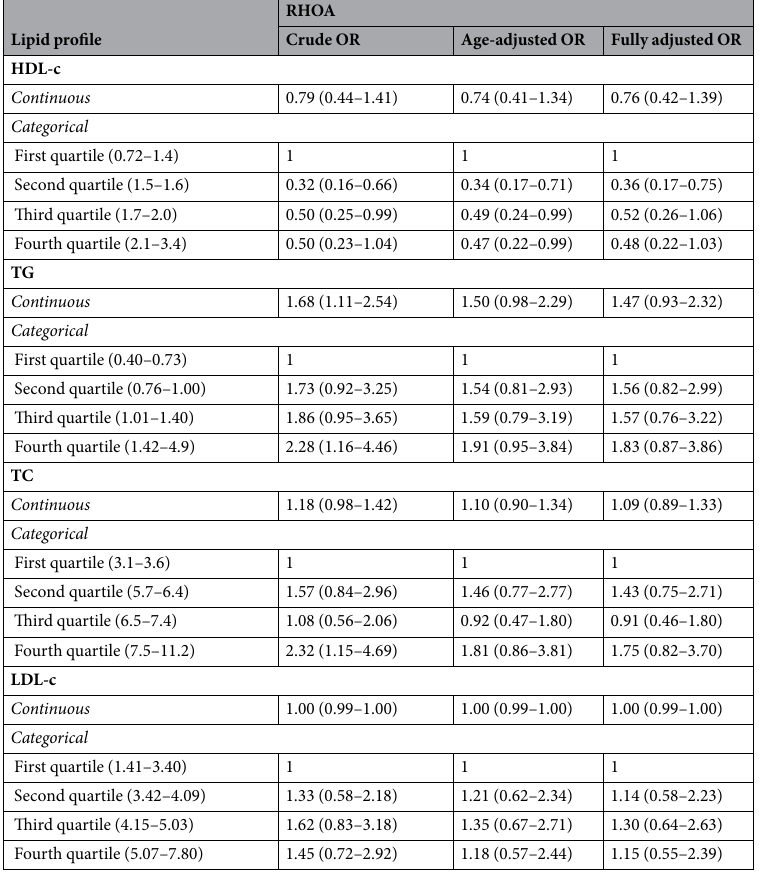
Table 3. Association between lipid measurements and incident radiographic hand osteoarthritis (RHOA) at 10 years of follow-up. * Quartiles (limits in mmol/L). Models adjusted for age, body mass index, blood pressure medication. ** Trend tests (fully adjusted models): HDL-c, high-density lipoprotein cholesterol (p = 0.009); TG, triglycerides (p = 0.033); TC, total cholesterol (p = 0.278); LDL-c, low-density lipoprotein cholesterol (p =